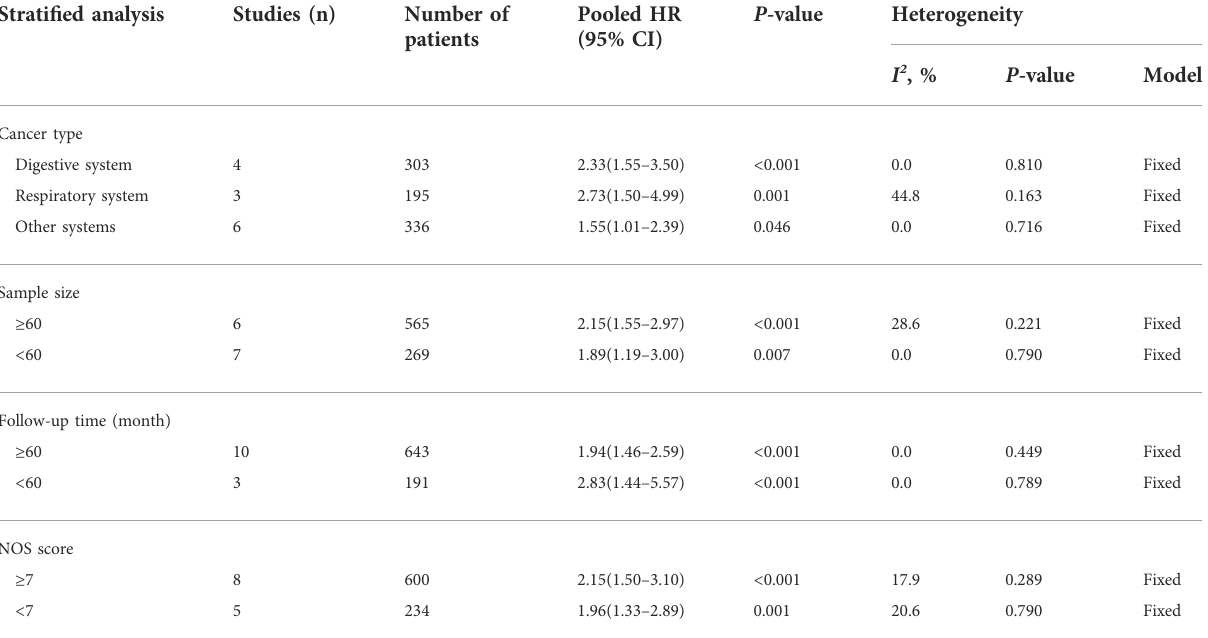
TABLE 2 Subgroup meta-analysis of pooled HRs for OS.